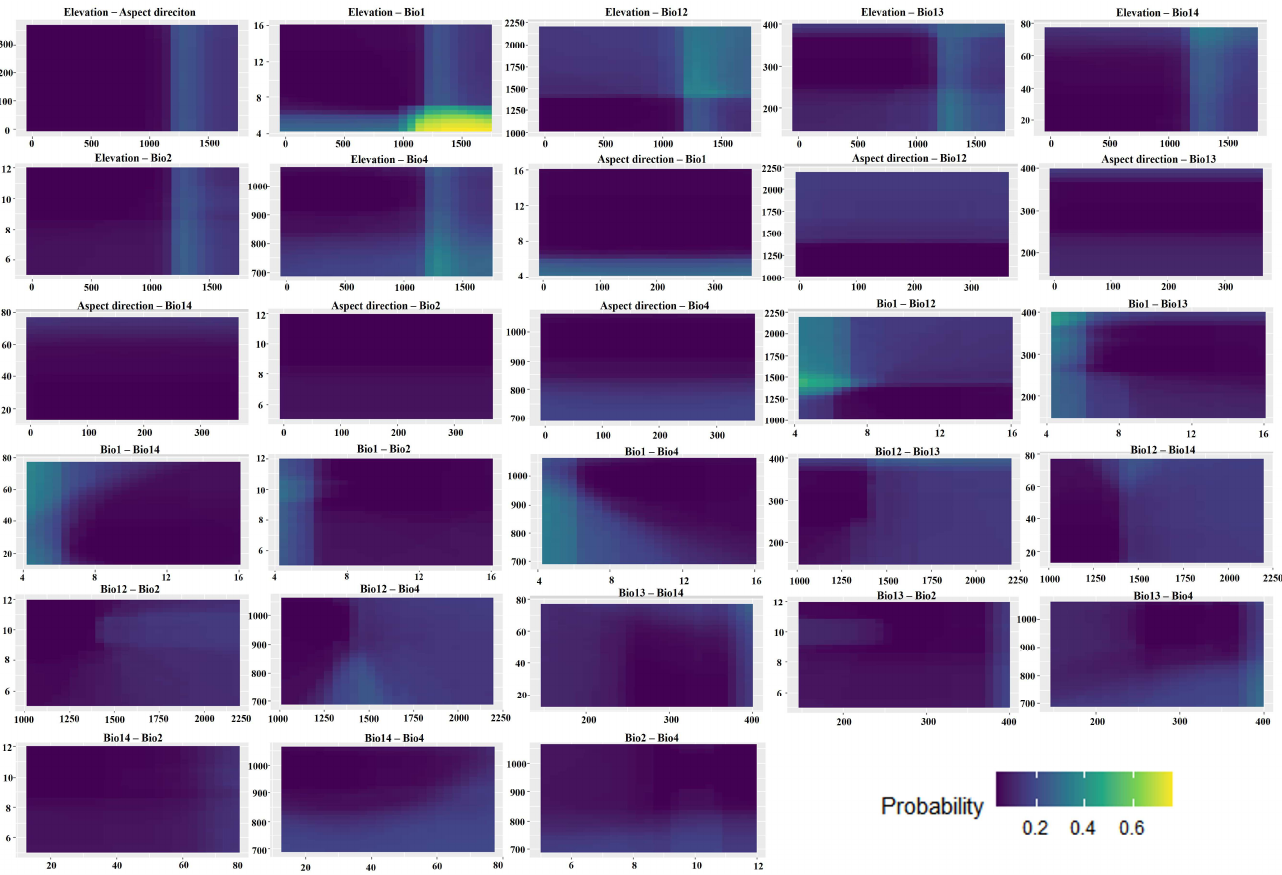
Figure 4. The analysis of relationships between independent variables through bivariate analysis.